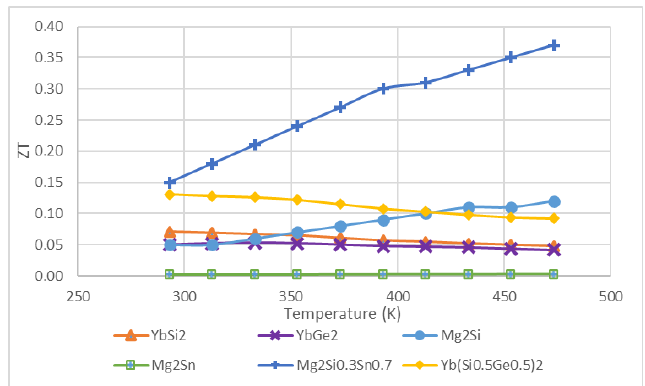
Figure 5. The advances in performance possible for Mg 2 Si and YbSi 2 when doped with Sn and Ge respectively: at 473 K, the ZT value of Mg 2 Si 0.3 Sn 0.7 is 0.37, which is over three times greater than that of Mg 2 Si. Although Yb(Si 0.5 Ge 0.5 ) 2 does perform significantly better than YbGe 2 and YbSi 2 , it proves to be a promising material for thermoelectric performance going forward due to its high power factor at room temperature (3.7 mWm − 1 K − 2 ). Data from